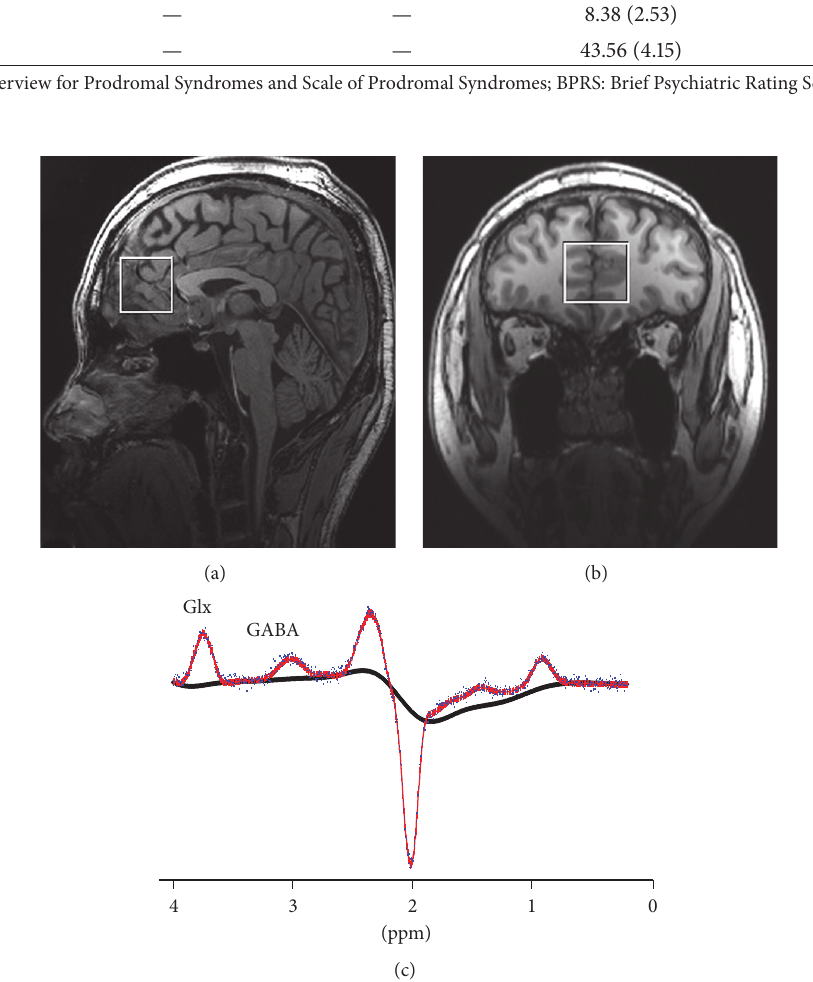
Figure 1: Midsagittal (a) and axial (b) views of the location of the 30 × 30 × 30 mm 3 voxel (white square) in the mPFC. (c) Representative MRS spectrum of GABA and Glx fitted by the LCModel from one HC. The blue line is the raw experimental spectrum. The red line is the model-fitting of the experimental spectrum. The black line is the background signal. The peaks of GABA and Glx are